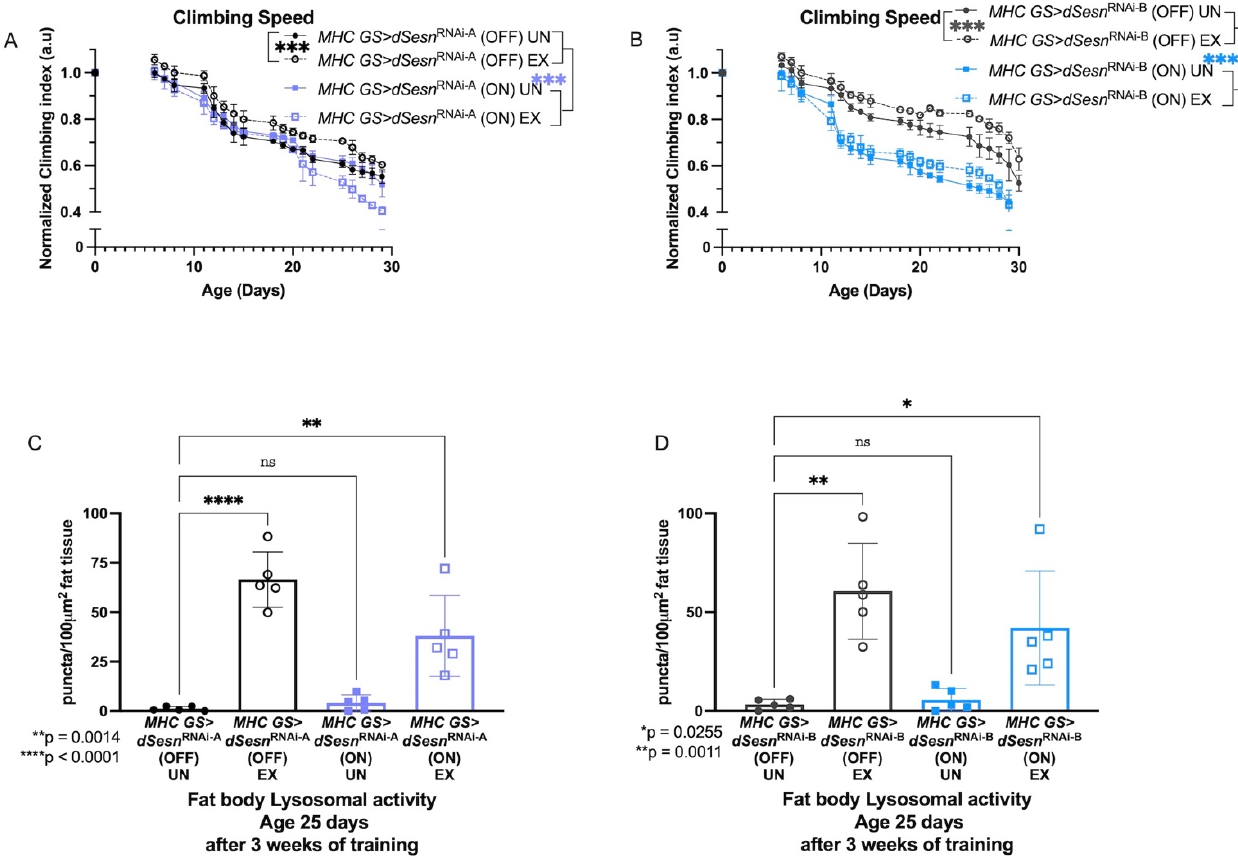
Figure 2. Sestrin RNAi in adult muscles abrogates exercise-dependent increases in climbing speed and lysosomal activity. ( A ) RNAi against Sestrin in adult muscles ( MHC GS > dSesn RNA-A (ON) UN) reduces climbing speed (2-way ANOVA, p ≥ 0.0489), and exercise further reduces climbing speed, particularly at later timepoints (2-way ANOVA, p ≤ 0.0184 after adult day 22). Control flies respond to exercise as normal. ( B ) A separate RNAi construct against Sestrin in adult muscles ( MHC GS > dSesn RNA-B (ON) UN) also reduces climbing speed (2-way ANOVA, genotype effect, p ≤ 0.0046 after adult day 8). Control flies respond to exercise as normal. Climbing experiments performed in duplicate, n ≥ 100 flies. ( C ) RNAi against dSesn in muscle reduces exercise-induced increase in lysosomal activity in fat body (ANOVA, p = 0.0014), but MHC GS > dSesn RNA-A (ON) flies still increase fat body lysosomal activity compared to unexercised siblings (ANOVA, p = 0.0030). ( D ) MHC GS > dSesn RNA-B (ON) flies also increase fat body Lysotracker staining after exercise (ANOVA, p = 0.0372). EX = cohort after 3 weeks of ramped, daily endurance training. UN = control unexercised flies exposed to identical training environment without running. ns or lack of brackets indicates no significant difference.